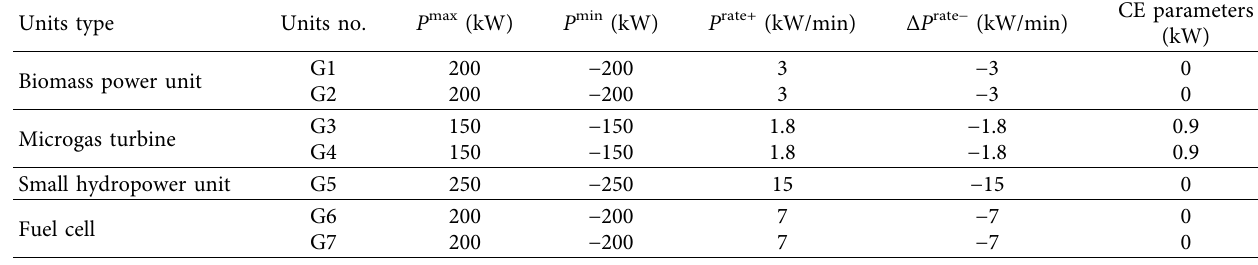
Table 2: Relevant parameters of three-area polymorphic energy system model.